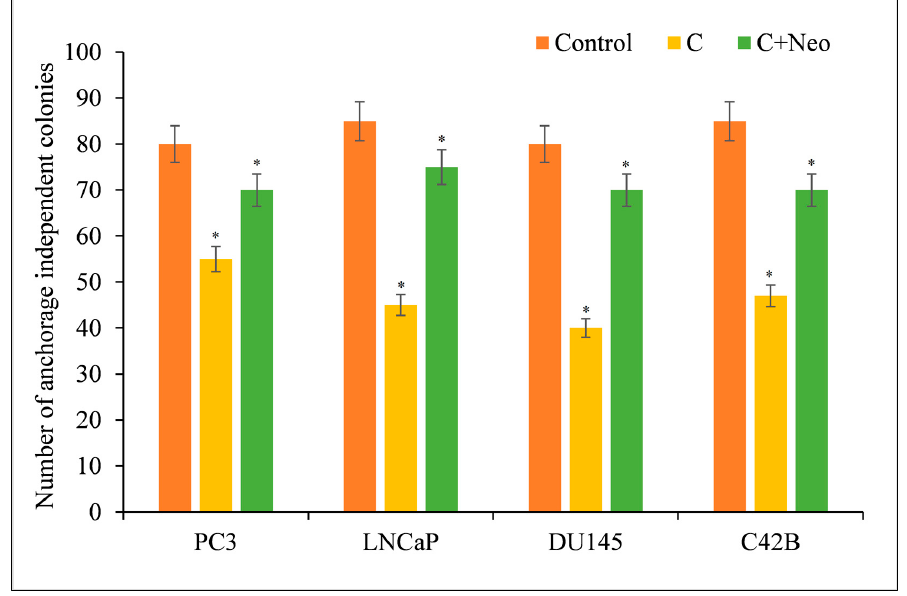
Figure 7. PC3, LNCaP, DU145, and C42B cancer cells (3 × 10 4 ) were plated in 24-well plates as described in Section 2. Cultures were supplemented with curcumin at a concentration of 25 µ M